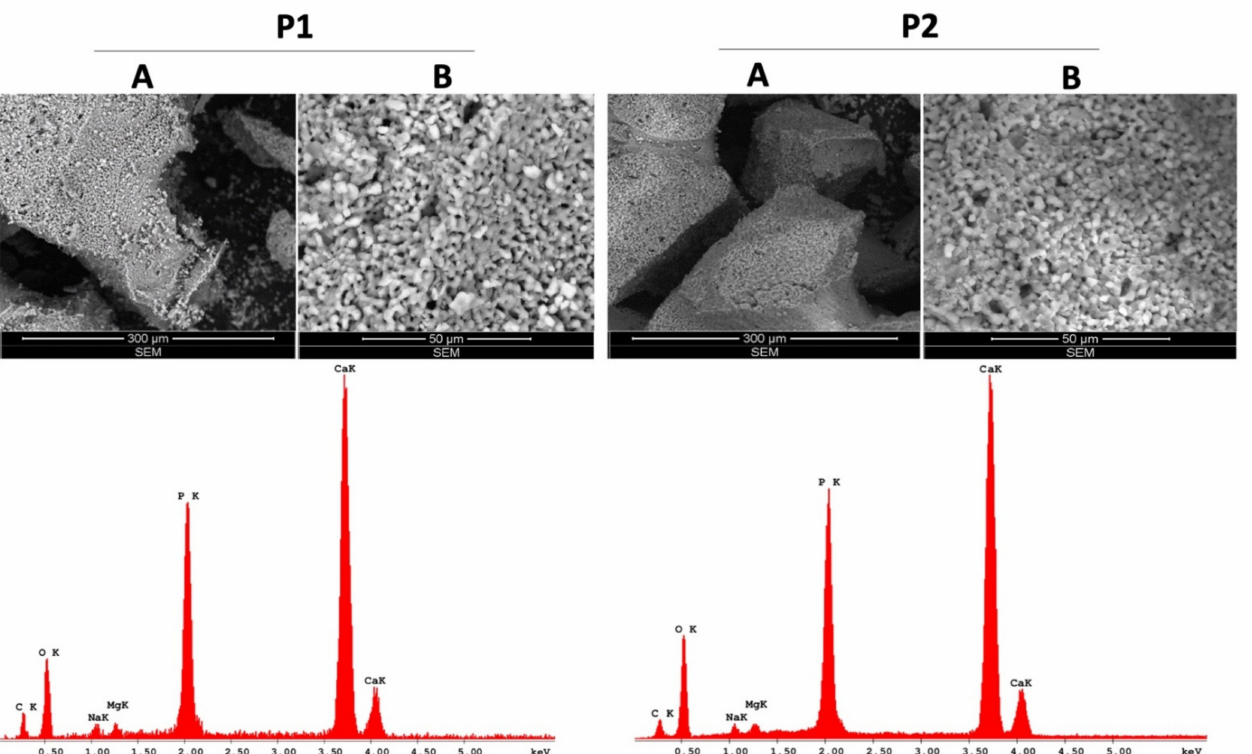
Figure 2. SEM–EDAX analysis of the traditional Cerabone ® ceramics (P1, P2); A —represents the general aspects of the samples and B —represents the ultrastructure details of the